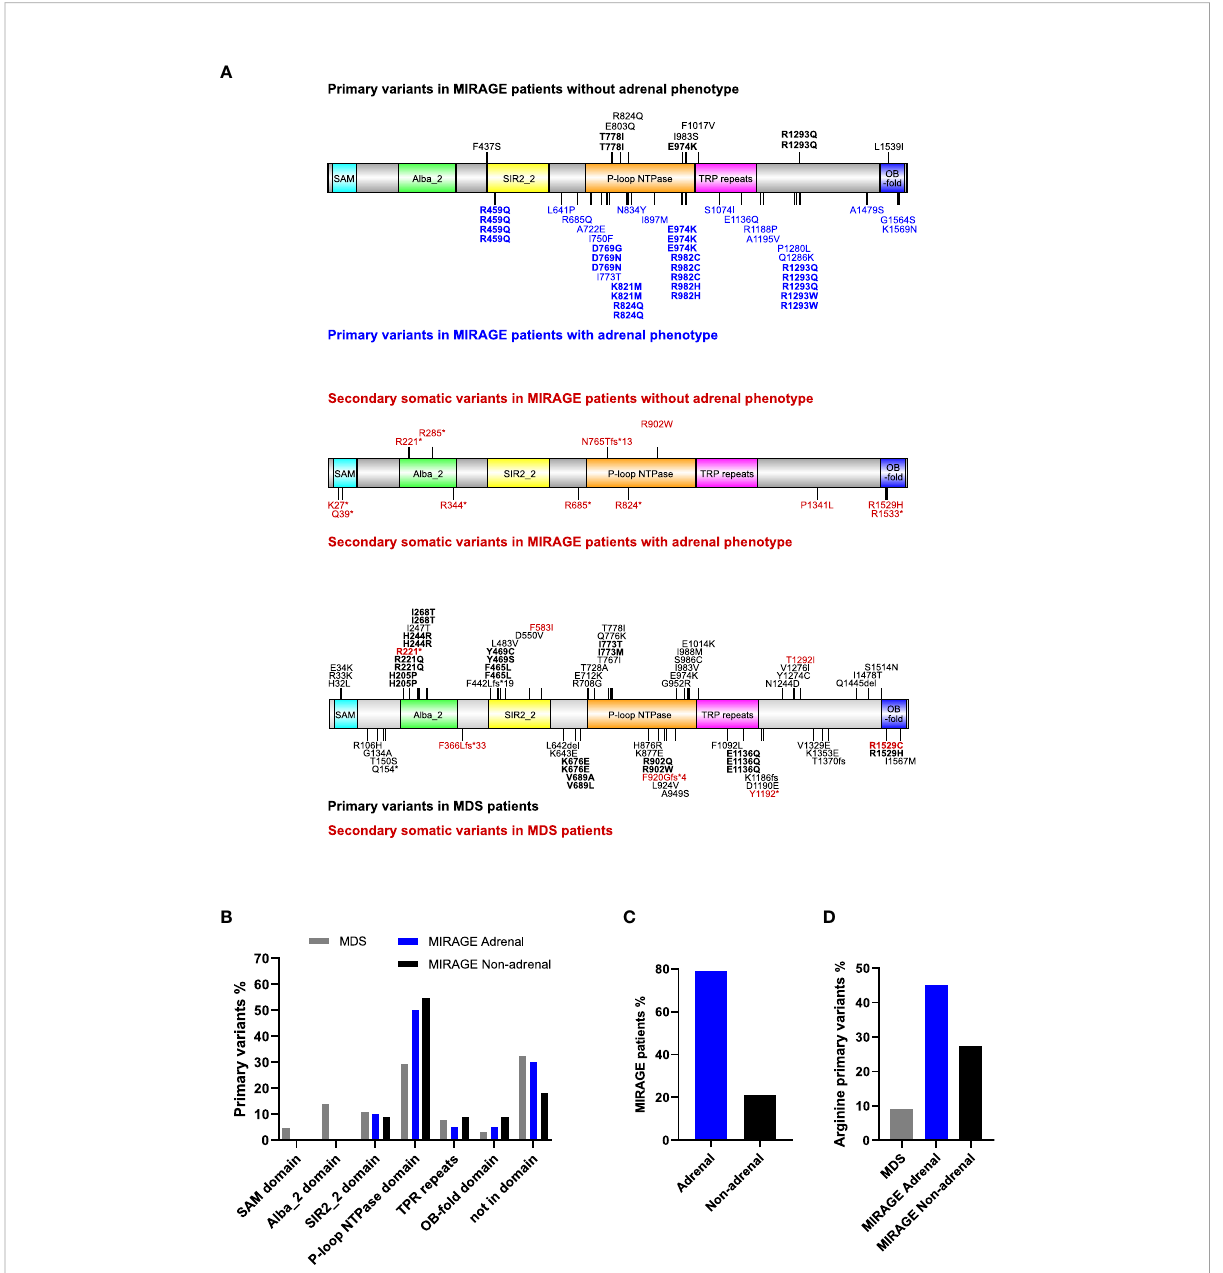
FIGURE 1 Overview of SAMD9 variants and relation to adrenal insuf fi ciency. (A) Depiction of SAMD9 showing the variants reported in individuals with MIRAGE syndrome (top diagrams) and those with myelodysplastic syndrome (MDS) (bottom diagram). Predicted domains are indicated by different colors. Codons with multiple reported cases are shown in bold. Secondary somatic variants are represented in red. (B) Distribution of SAMD9 primary variants across the speci fi c domains for individuals with MDS, and MIRAGE with or without adrenal insuf fi ciency (Note: secondary somatic variants excluded). (C) MIRAGE patients reported to date with or without adrenal insuf fi ciency. (D) Percentage of gain-of- function variants involving arginine residues in individuals with MDS and MIRAGE syndrome, with or without adrenal insuf fi